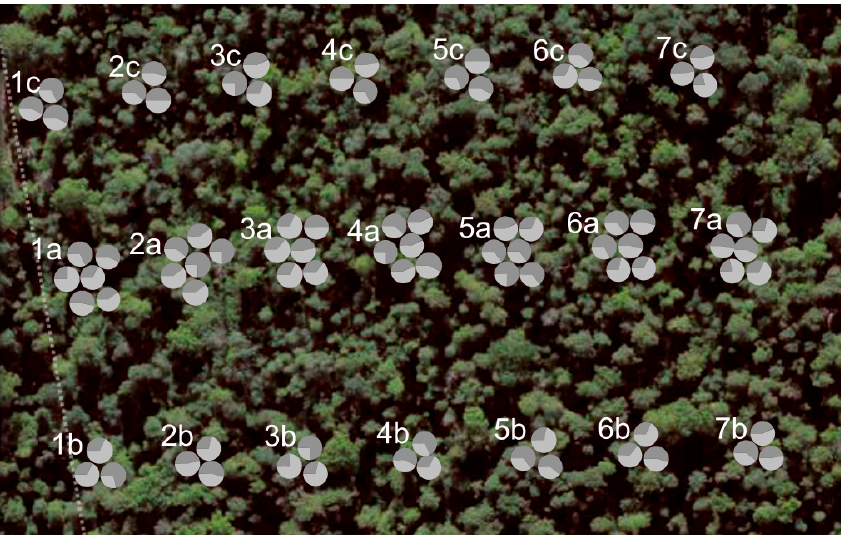
Figure 8. Spatial distribution map of sampled European ash ( Fraxinus excelsior L.) juveniles regen- erating on a sanitary clearcut site (see Figure 1 for the principal sampling scheme). Pie charts show the assignment of individual juvenile MLGs to the two most likely genetic clusters, as revealed by STRUCTURE (indicated in different shades of grey).